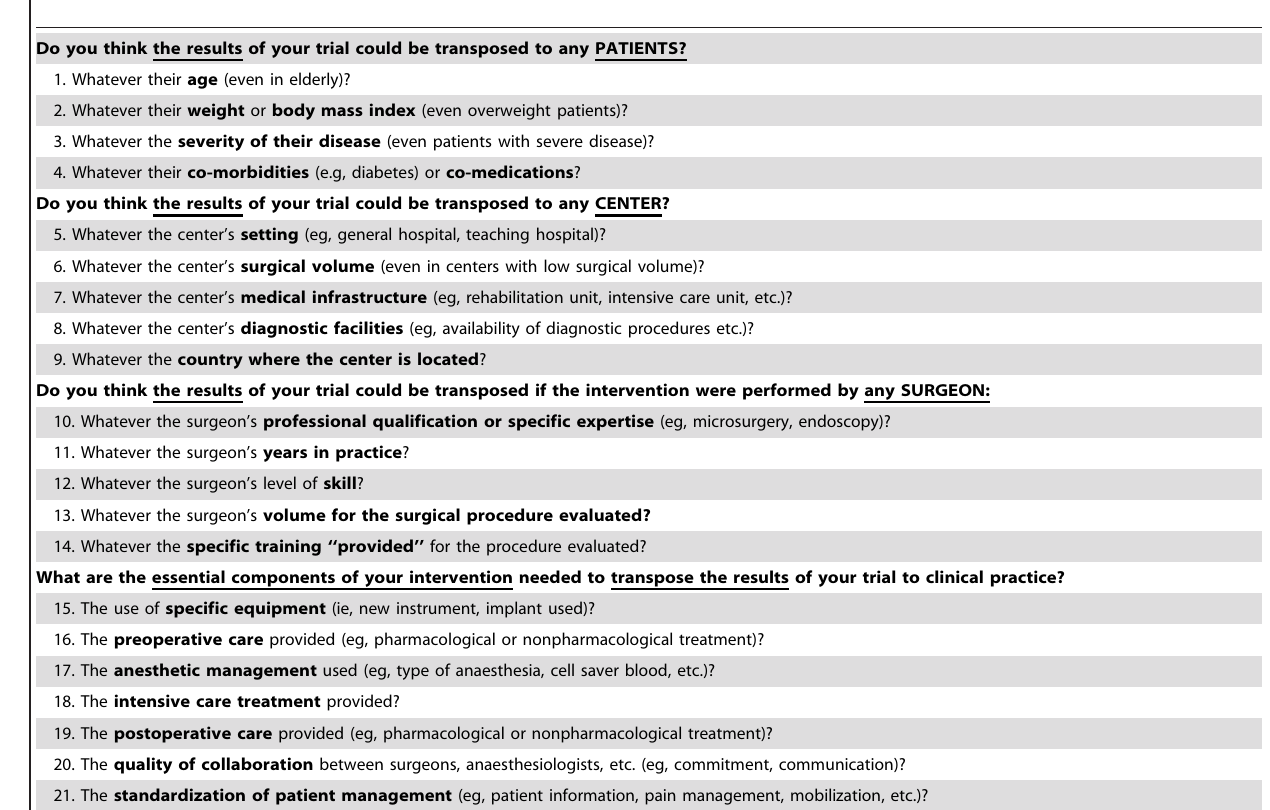
Table 4. The final